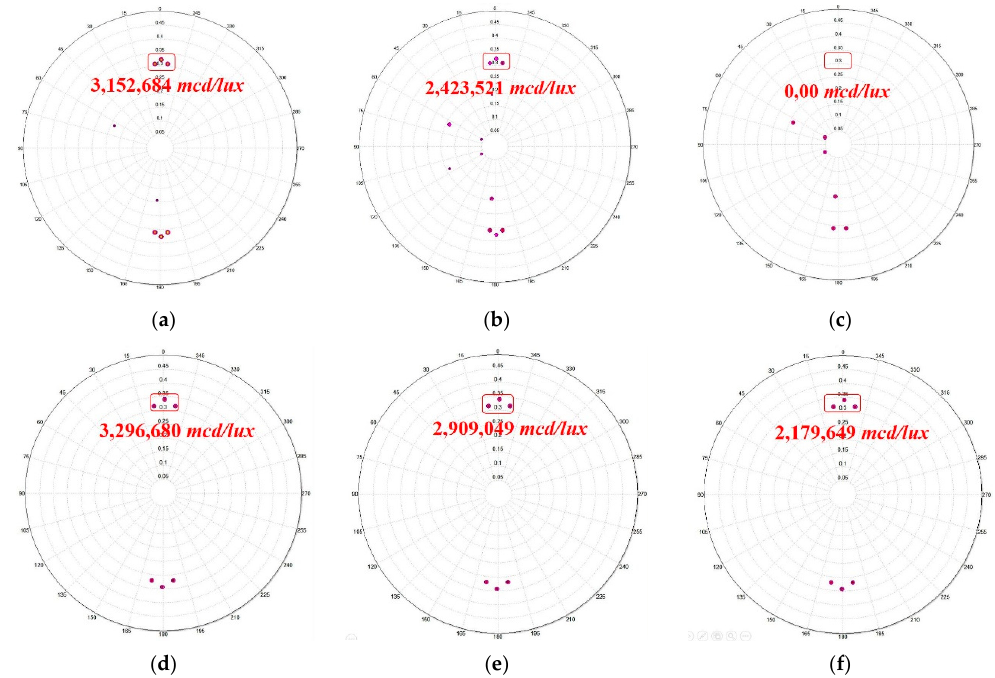
Figure 17. Intensity distributions and R I for 0° incident light beam on anterior, central and posterior regions of the commercial CCCR, which are shown in ( a )–( c ) respectively, and those of the optimized CCCR are shown in ( d )–( f ).